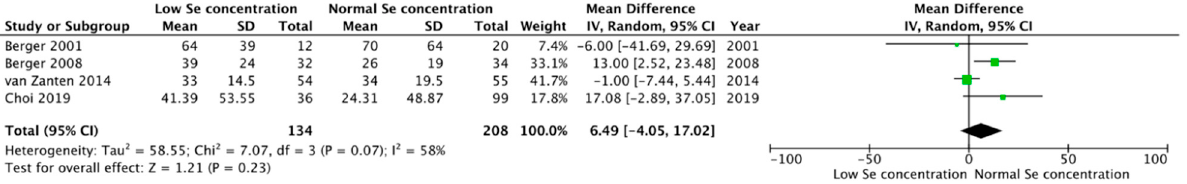
Figure 5. Forest plot of the impact of low serum Se concentration on the length of intensive care unit stay in patients with severe trauma.